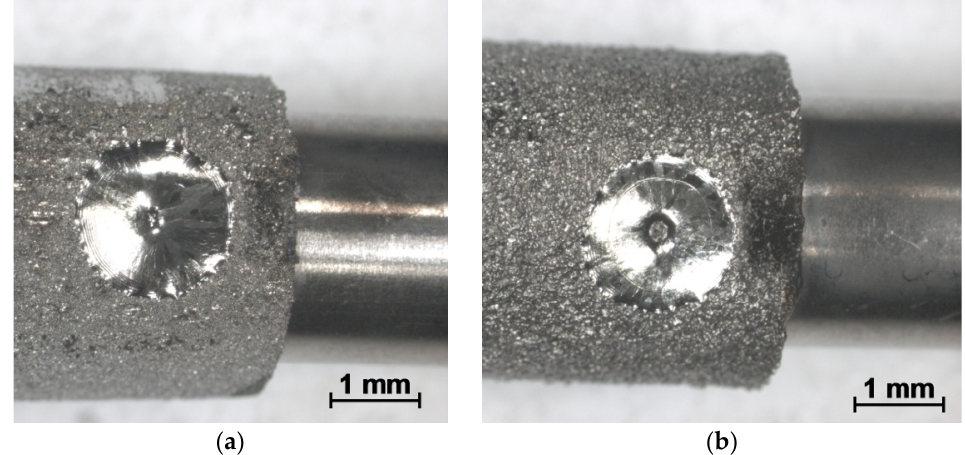
Figure 4. Laser spot welds for superposed connector to tube geometry: ( a ) SLM and ( b ) EBM.